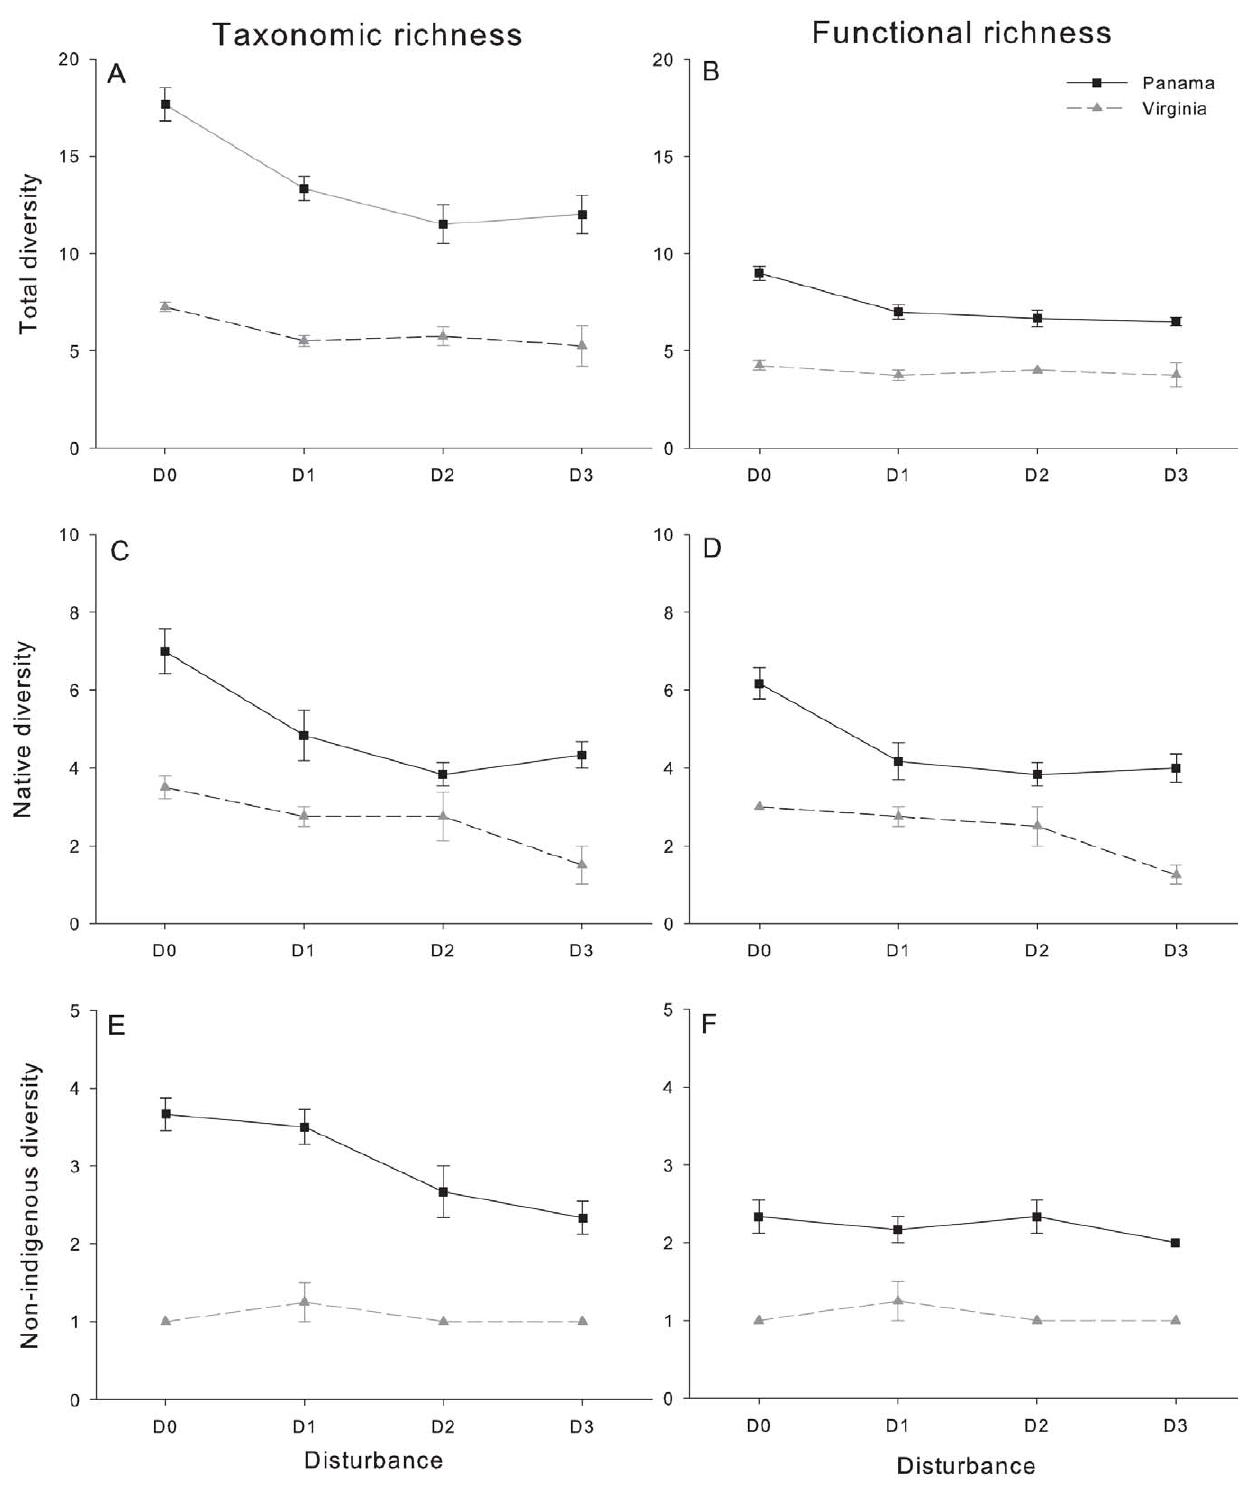
Figure 3. Relationship between disturbance and different measures of diversity in Virginia and Panama. Diversity measures are: total taxonomic richness (A); total functional richness (B); native taxonomic richness (C); native functional richness (D); non-indigenous taxonomic richness (E); and non-indigenous functional richness (F). Means and standard errors are indicated (n=4 in Virginia; n=6 in Panama). Disturbance treatments abbreviations are as in Figure 1.